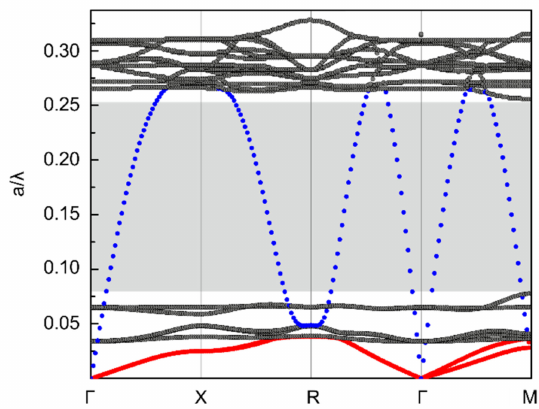
Figure 2. Phonon band structure of the pentamode structure (with geometrical parameters D / a = 2 / 37.3 and d / a = 0.5 / 37.3). The first two branches emphasized using red dots and the third using blue dots represent, respectively, are two transverse wave modes and a longitudinal wave mode. The light grey region is the single-mode band gap, in which only the longitudinal wave can propagate.